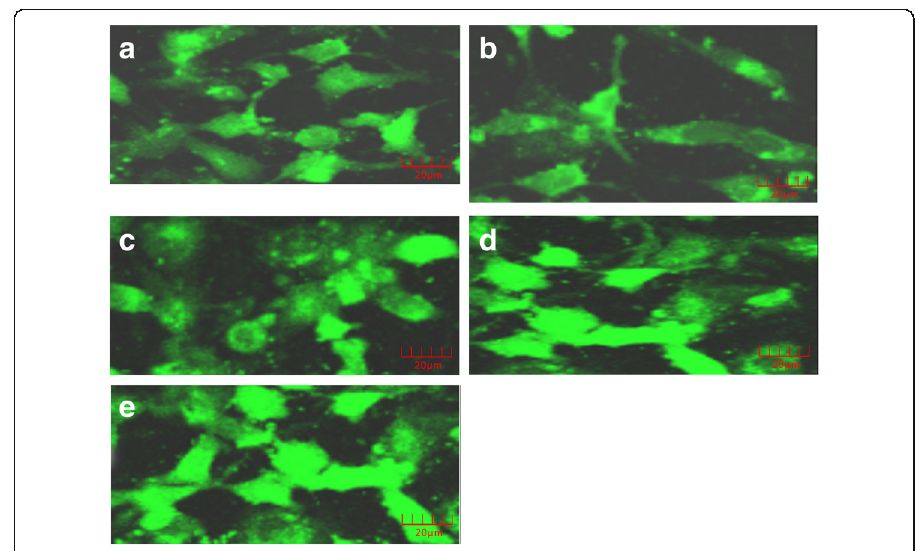
Fig. 2 Laser confocal microscopy images of the changes in Ca 2+ fluorescence intensity. a – blank group; b – TGF- β 1 group; c, d and e – TGF- β 1 + low, middle and high dose of calcium ionophore A23187 groups